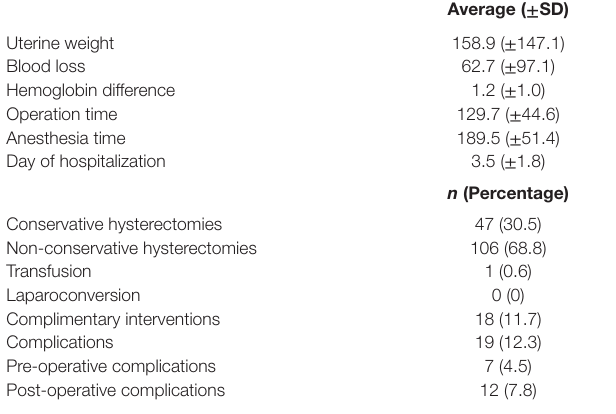
TaBle 2 | surgical and post-operative data.